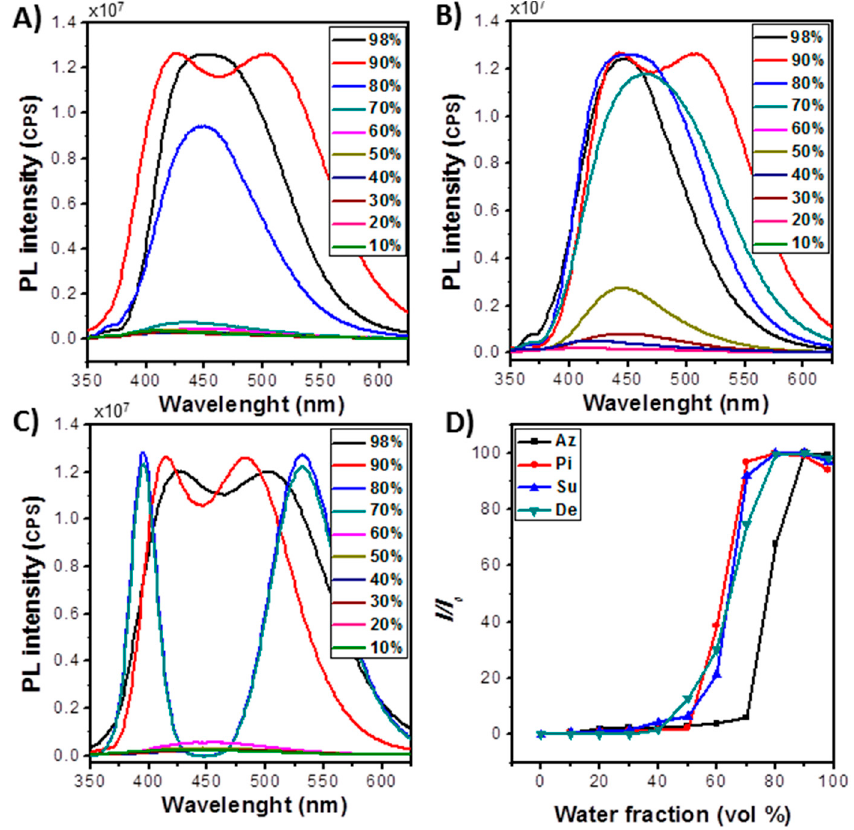
Figure 3. The fluorescence emission spectra of ( A ) TPE-Az , ( B ) TPE-Su, ( C ) TPE-Pi (10 µ M) in THF/water at various water fractions ( λ ex = 365 nm ) and ( D )The fluorescence intensity changes of TPE-Se , TPE-Az , TPE-Su and TPE-Pi at 475 nm as a function of water fraction in THF solvent mixture.